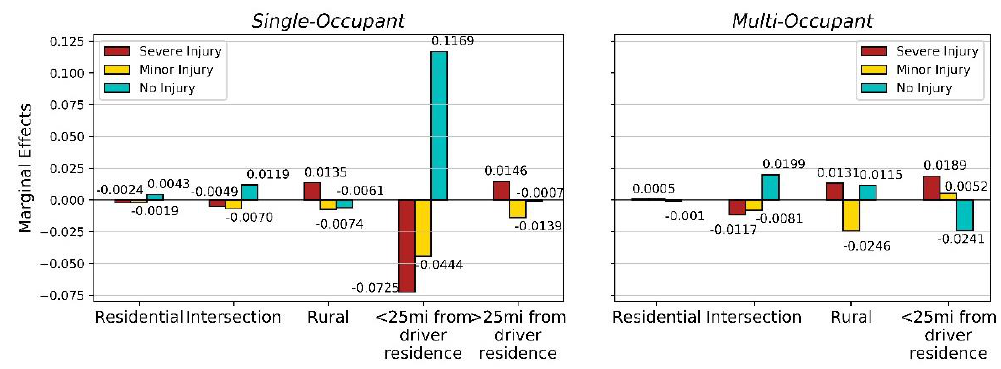
ff ects of Location Figure 2. Estimated marginal effects of Location Characteristics. Figure 2. Estimated marginal e